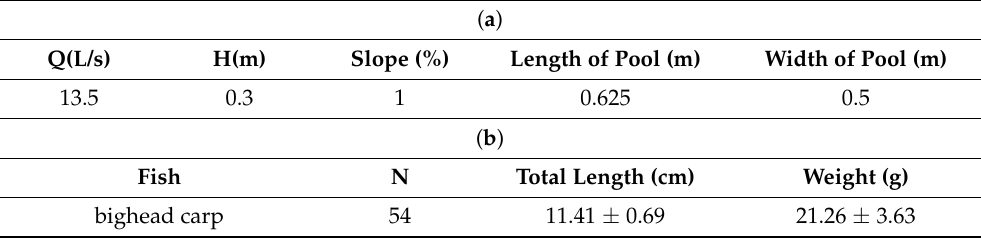
Table 1. ( a ) The experimental conditions for the test. ( b ) Details of tested fish: the total number of tested fish, total length and weight statistics for fish used in the experiments are